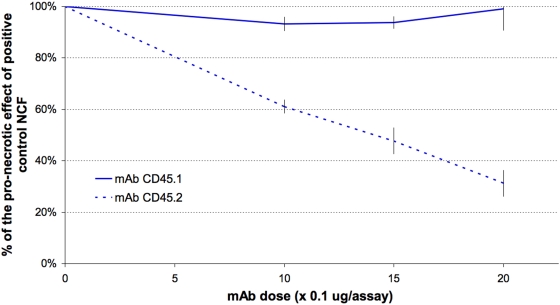
CD45 neutralization protects mouse splenocytes against the lethal effect of the trypanosomal non-cytosolic fraction in a dose-dependent way, provided the neutralizing mAb targets the epitope typical of CD45.2 rather than that characteristic of CD45.1.Splenocytes were from C57BL/6 mice, which are homozygous for the CD45.2 genotype. Values are means±SD of three independent experiments.